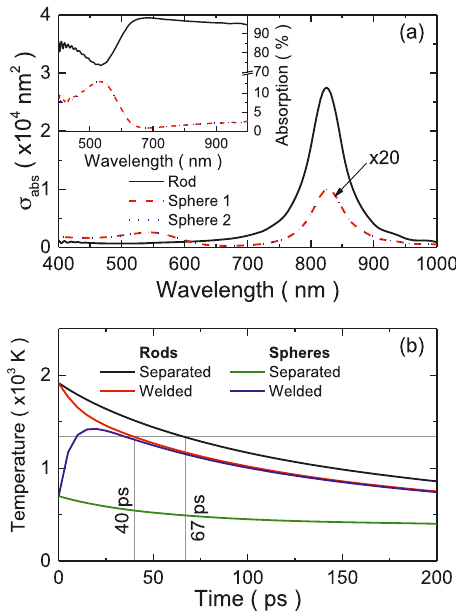
Figure 6: (a) Absorption cross-section ( σ abs ) of the individual par- ticles formingthe structureof a rod with two spheres at the tips. The inset represents the relative absorption for each particle: the rod absorbsover95%oftheenergy.(b)Temperatureevolutionoftherod and the spheres when they are separated 2 nm (black and green lines, respectively) or welded (red and blue lines). The grey hori- zontallinerepresentsthemeltingtemperatureofbulkgold.Thegrey vertical lines represent the time when the rod temperature falls below the melting point of bulk